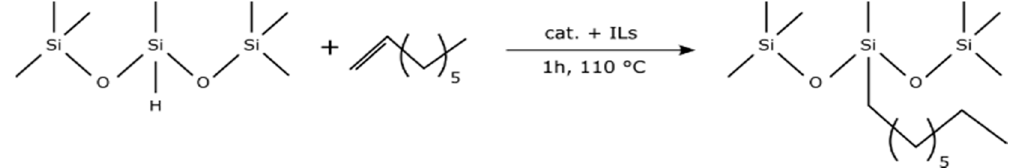
Figure 2. Hydrosilylation reaction of 1-octene and 1,1,1,3,5,5,5-heptamethyltrisiloxane.